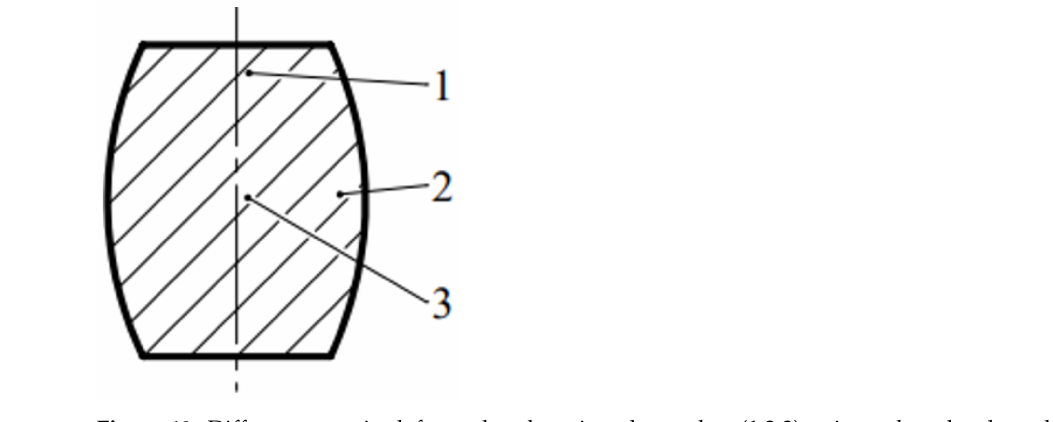
Figure 13. Different areas in deformed and sectioned samples: (1,2,3) points where hardness has been measured.